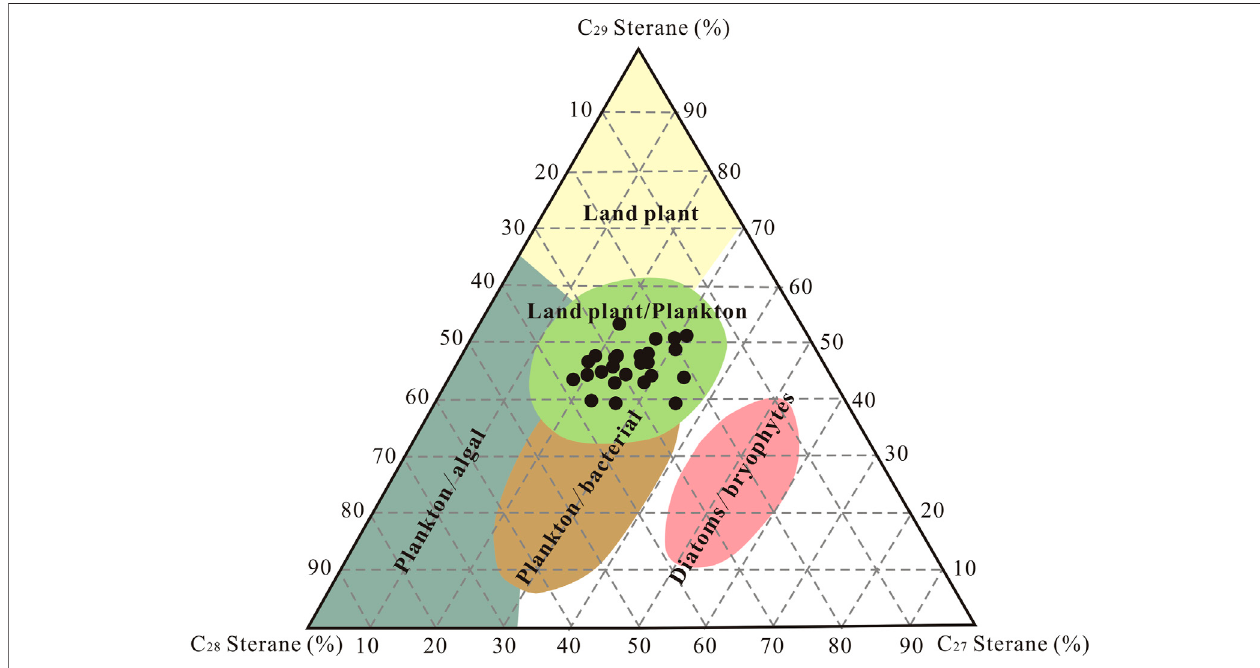
FIGURE8| Sedimentaryenvironmentofshaleinstudyarea (A) TherelationshipbetweenPr/n-C 17 andPh/n-C 18 ; (B) TherelationshipbetweenPr/PhandC 27 /C 29 .